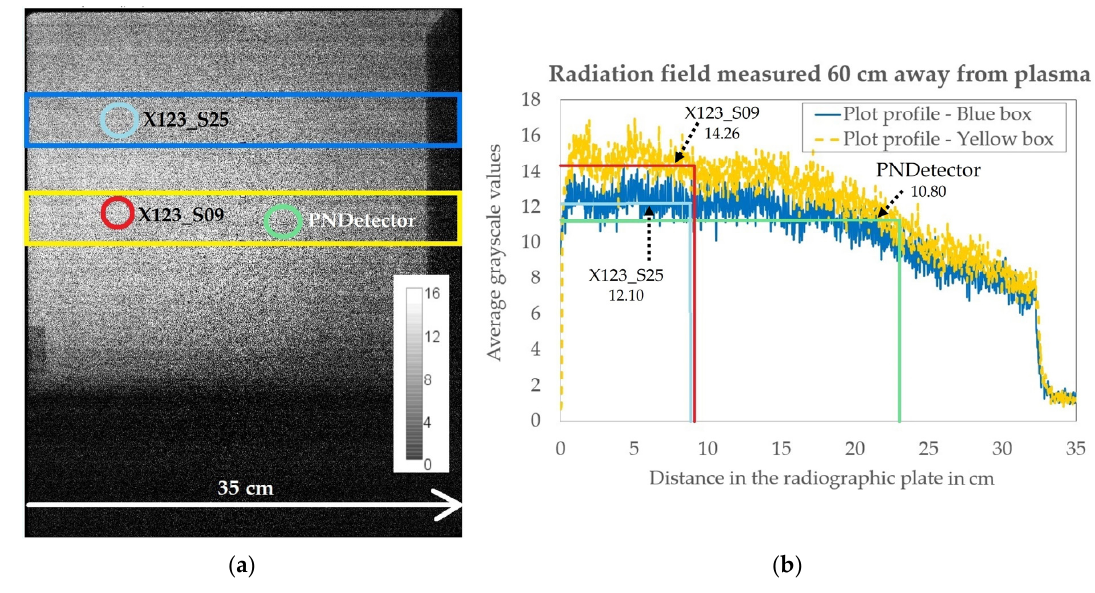
Figure 2. Grayscale image captured with the radiographic imaging plate ( a ) placed 10 cm in front of the three spectrometers used in this study. The blue and yellow rectangles are the areas used to calculate the X-ray intensity profile shown in the plot ( b ). The continuous decrease in grayscale value with an increased distance on the x -axis revealed that the PN spectrometer (PNDetector) received less X-ray intensity in comparison to the two X-123 spectrometers. Additionally, X123_S25 received about 14.5% less radiation than the X123_S09 spectrometer.